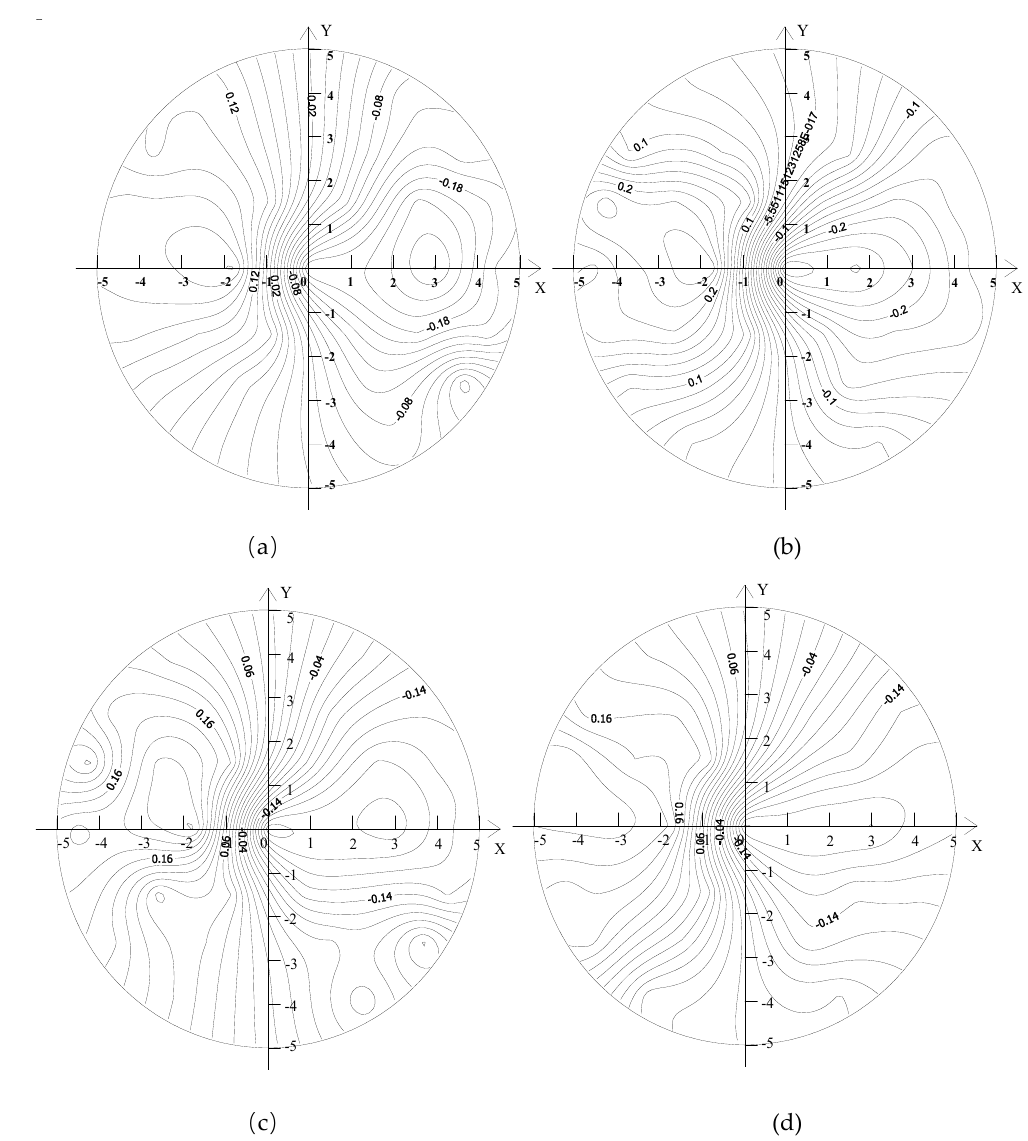
Figure 10. Radial velocity distribution of the downstream sections of capsules: ( a ) L / d = 2.5, Z = 0.2m; ( b ) L / d = 2.14, Z = 0.2m; ( c ) L / d = 2.5, Z = 3m; and ( d ) L / d = 2.14, Z = 3m.